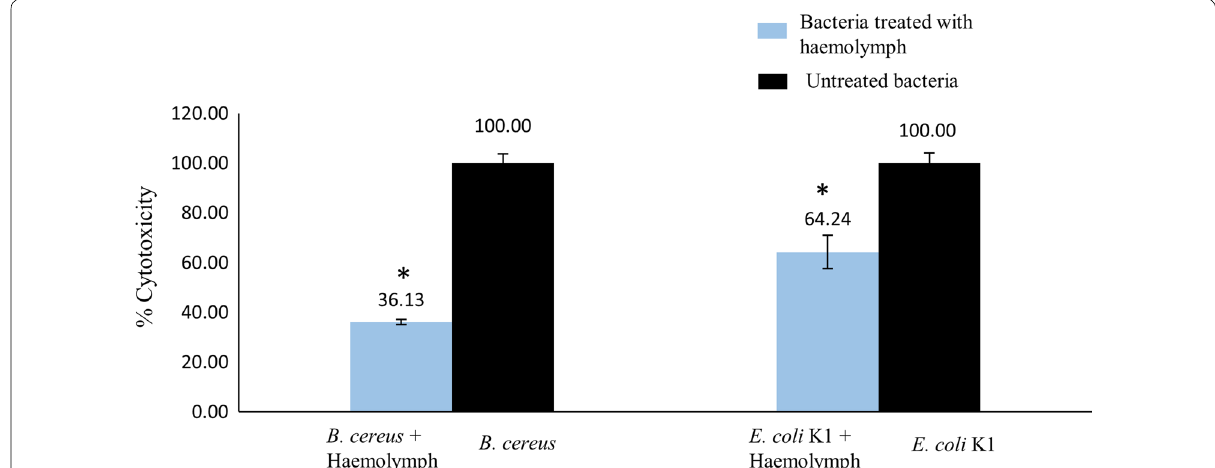
Fig. 3 The haemolymph of red centipede was aspirated and tested in cytopathogenicity assay against Human Keratinocyte HaCaT monolayers. 10% haemolymph was incubated with 10 6 bacterial cells for 2 h at 37 °C, followed by the co-incubation with HaCaT monolayers in 5% CO 2 incubator at 37 °C for 18–20 h. Untreated bacteria incubated with HaCaT monolayers were used as control. Next day, supernatent containg lactate dehygrogenease enzyme were collected, centrifuged and determined by Rosche cytotocicity detection Kit as per guidelines. Significant reduction was observed in the cytopathogenicity caused by the pre-treated bacteria incubated with haemolymph as compared to untreated bacteria. B. cereus showed up to 36% and E. coli K1 showed up to 64% cytotoxicity to human cells when pre-treated with haemolymph in contrast to untreated bacteria which showed 100% cytopathogenicity to human cells. The results are representative of several experiments performed in duplicates and expressed as the mean standard ±